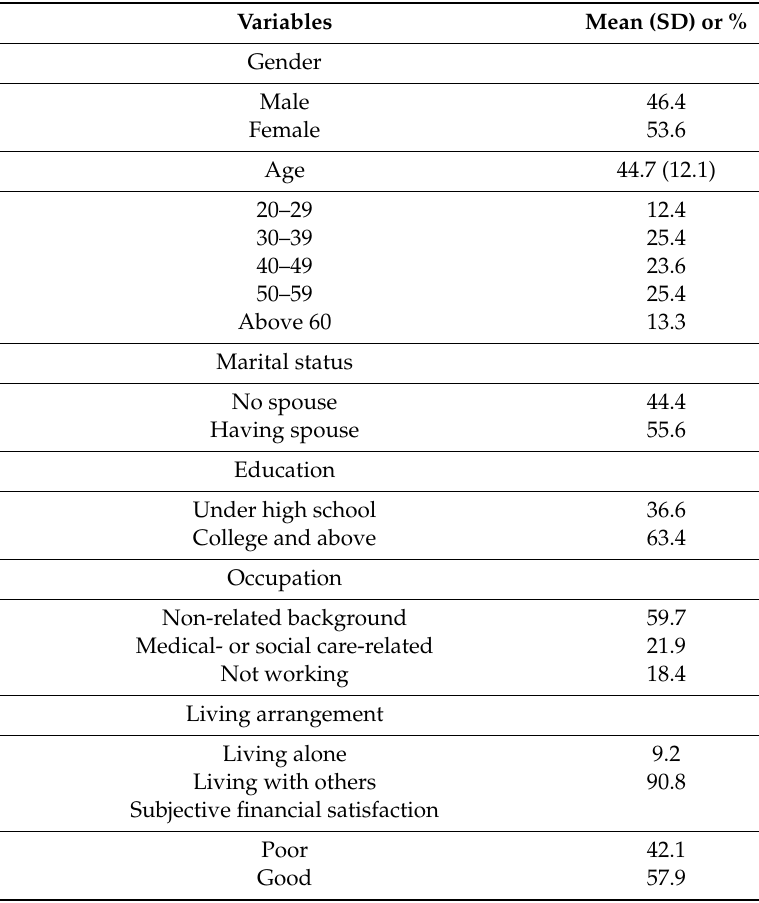
Table 1. Description of the